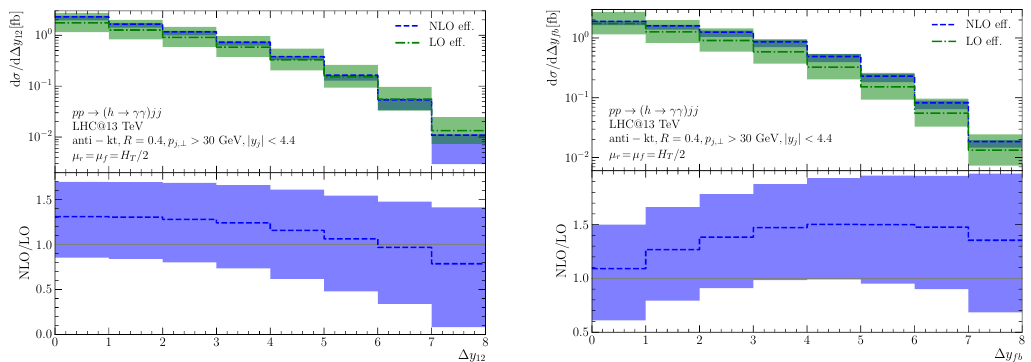
Figure 8 . The distribution of the rapidity separation between the hardest jets (left) and the most forward and backward jets (right) of Higgs-plus-dijet production for LO (green, dot-dashed) and NLO (blue, dashed) both in the in(cid:12)nite top mass limit. The bottom panel shows the NLO K -factor in each case. The results are obtained with (cid:22) r = (cid:22) f = H T = 2, and should be compared to those on (cid:12)gure